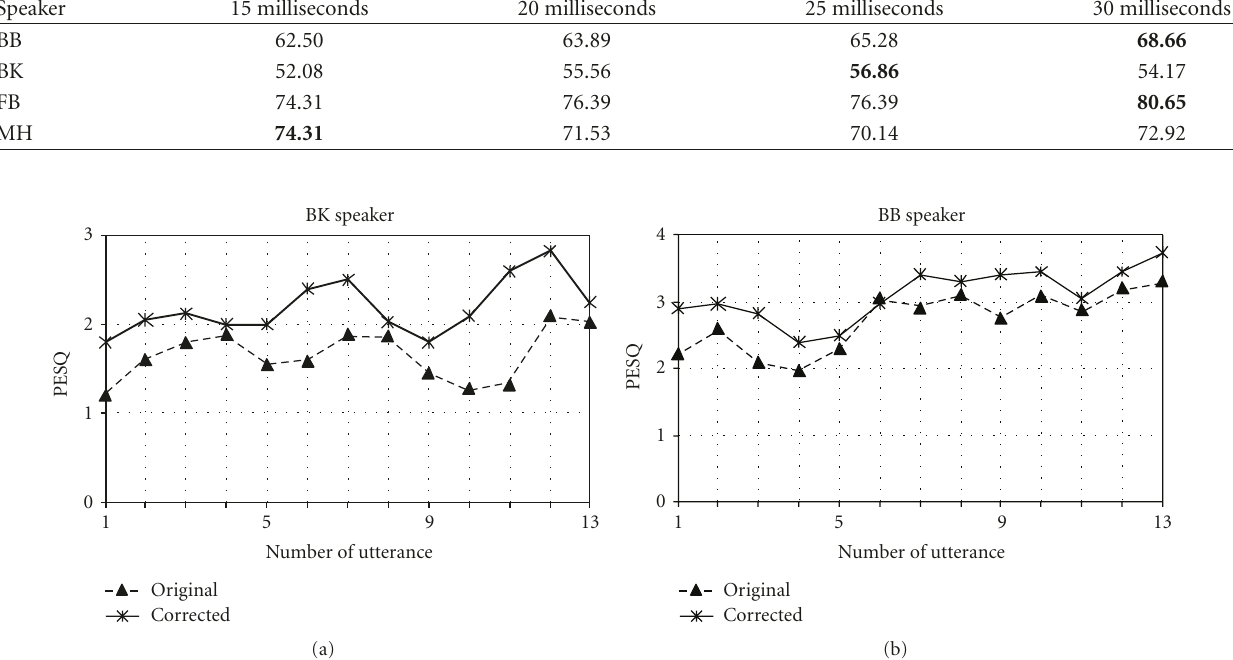
Table 1: The ASR accuracy using 13 MFCCs and their first and second derivatives and variable Hamming window size. Dysarthric